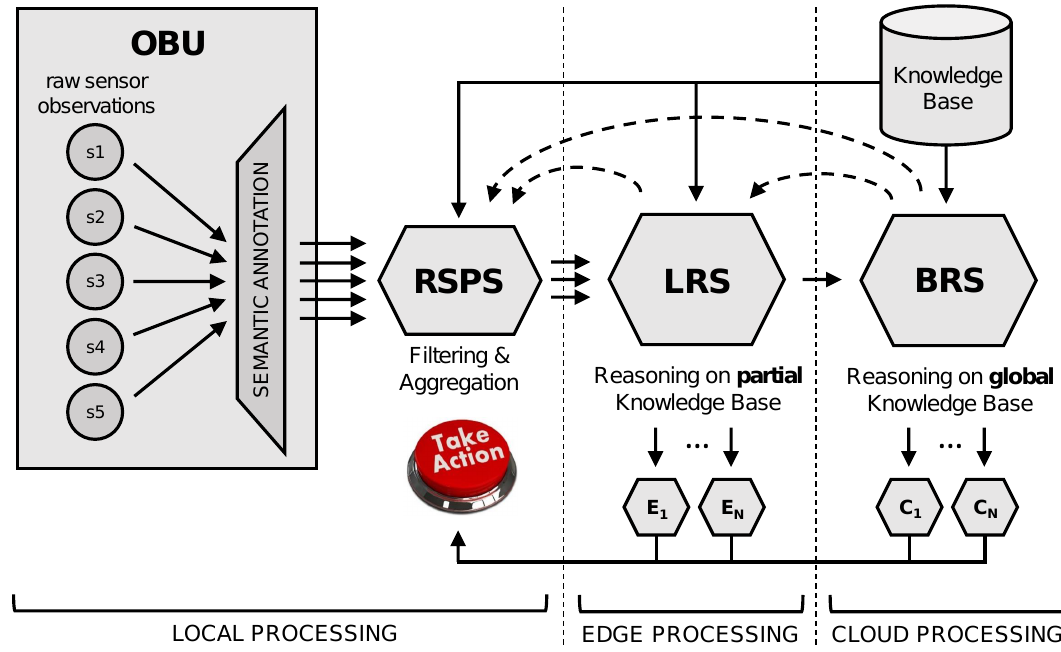
Figure 1. High-level architecture of the proposed cascading reasoning framework. The blocks represent the several components, the arrows indicate how the data flows through these components. The dotted arrows indicate possible feedback loops to preceding